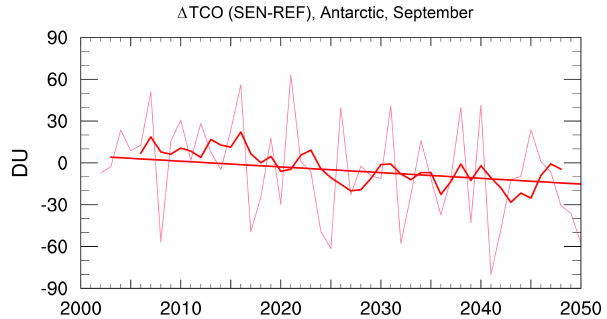
Figure 5. Temporal evolution of TCO differences (in DU) between SEN-C2-fCFC11_2050 and REF-C2 (i.e., SEN minus REF) for the Antarctic region (70–90 ◦ S) in September. The thicker curve shows the 5-year running mean. The corresponding line shows the trend estimate between the unsmoothed time series using a multiple linear regression – including differences of temperature anomalies as the dependent variable – which accounts for possible autocorrelation with lag 1 (see text for details).